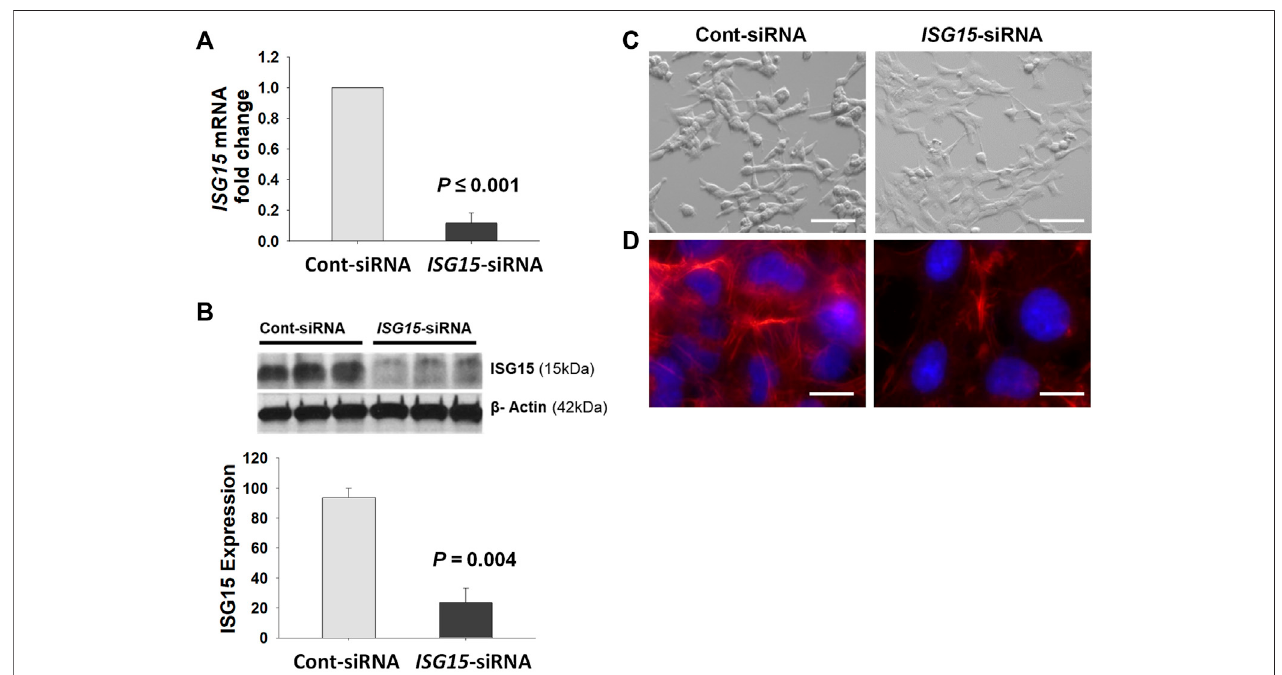
FIGURE5| Decreased ISG15 expression altersHTR8/SVneo cellmorphologyandreduces F-actinlevels. (A – D) ISG15 mRNA (A) andprotein levels (B) aswellas cellmorphology (C) andTRITC-conjugatedPhalloidin(red) fl uorescencestainedF-actinlevels (D) arerepresentedin ISG15 -siRNAvs.control-siRNAtransfectedHTR8/ SVneo cells. Bars represent Mean ± SEM and compared by using t -test, n = 3, Scale bars = 30 µm (C) , Scale bars = 6 µm (D).